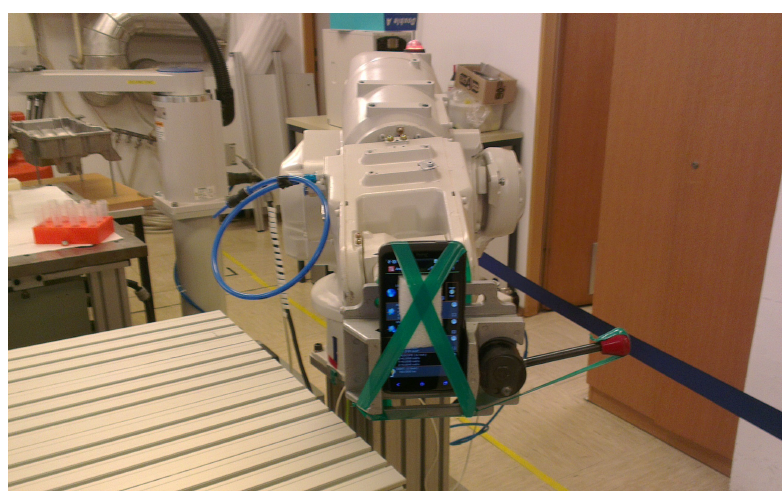
Figure 2. Robotic Arm used in the scenario with one of the Phones attached.